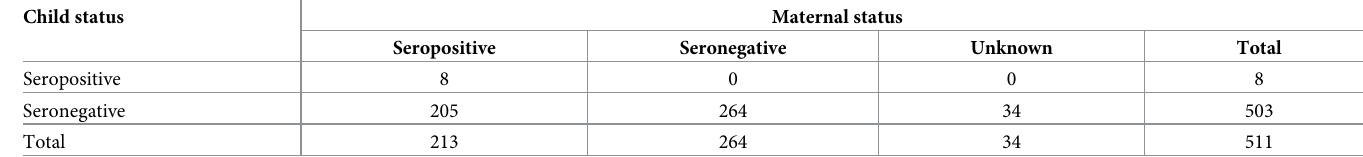
Table 4. Seropositivity for Trypanosoma cruzi infection in children born after the interventions according to maternal serostatus. Pampa del Indio, Chaco.